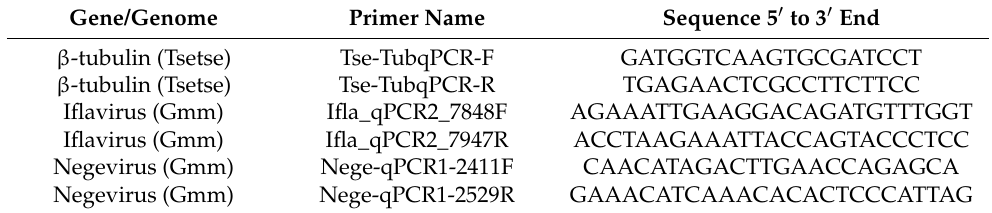
Table 1. Primers used for quantitative